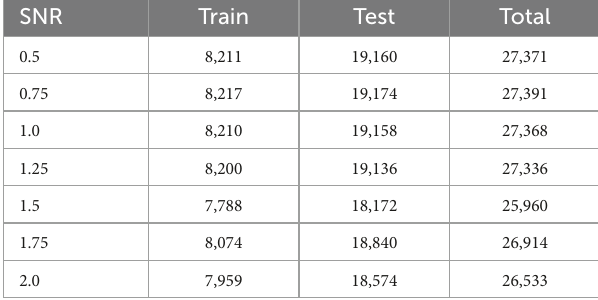
TABLE 3 Number of training and testing dataset per SNRs in dataset